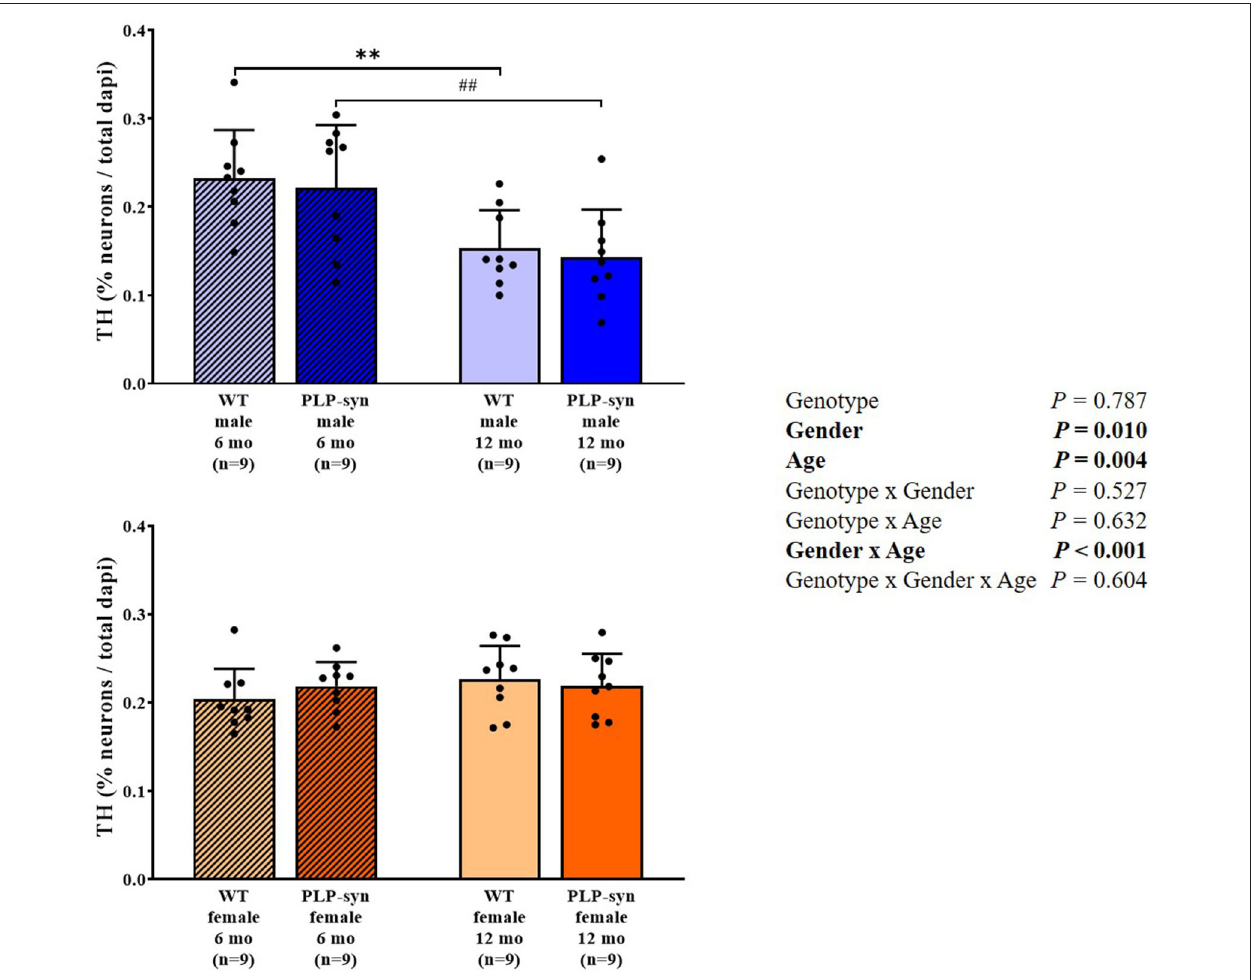
FIGURE 8 | Tyrosine hydroxylase immunohistochemistry in 6 and 12 months, male and female, WT and PLP- α -syn mice. TH, tyrosine hydroxylase. Counts were in 100 µ m ² areas where TH neurons were counted and compared to total dapi counts. Black circles represent individual points. ** P < 0.01 vs. WT male 6 mo. ## P + < 0.01 vs. PLP- α -syn male 6